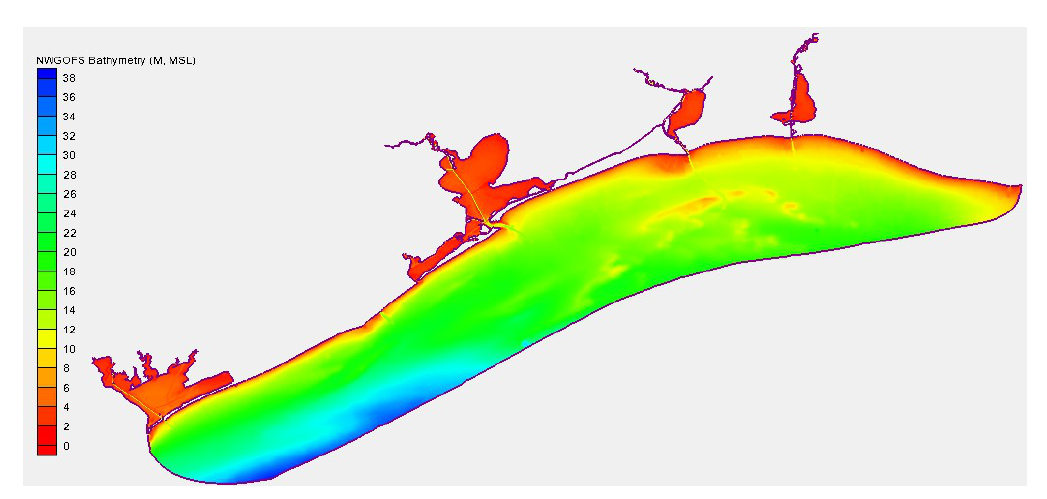
Figure 4. Northwest Gulf of Mexico Operational Forecast System (NWGOFS) bathymetry map.